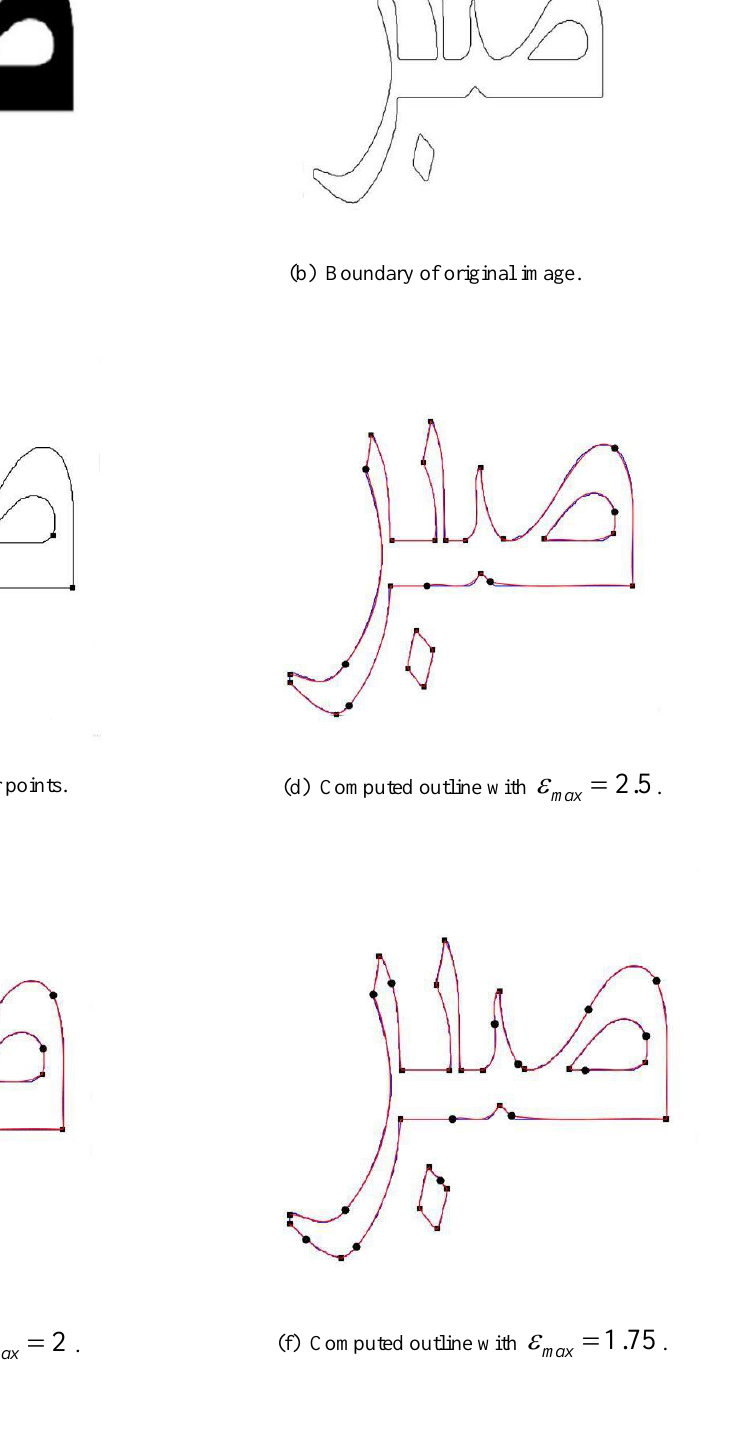
Figure 3. Captured shape of the Arabic word "Sabr". The black and red lines show the original and computed curves, respectively